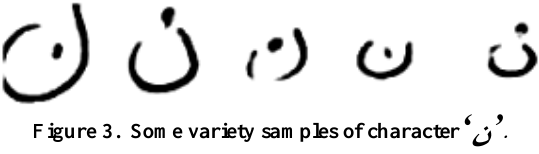
Figure 3. Some variety samples of character ‘ ﻥ ’